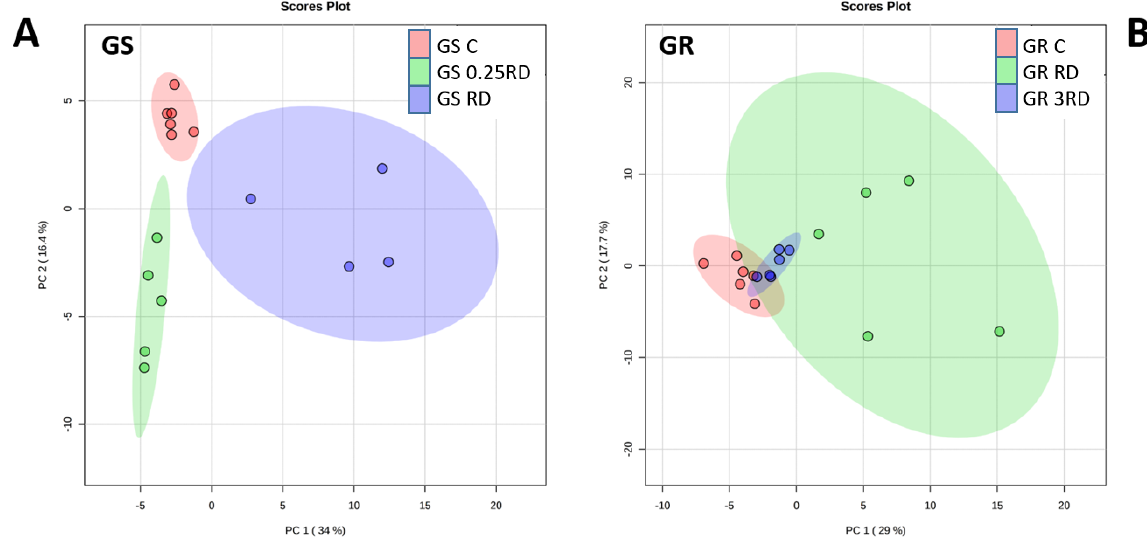
Figure 2. Principal component analysis (PCA) of metabolites detected by GC-MS in glyphosate-sensitive (GS; ( A ); left ) and glyphosate-resistant (GR; ( B ); right ) Amaranthus palmeri plants. Plants were not treated (control, C; in red) or treated with glyphosate at two doses: GS population with 0.25 RD (field recommended dose, in green) or RD (in purple); GR population with RD (in green) or 3 RD (in purple).